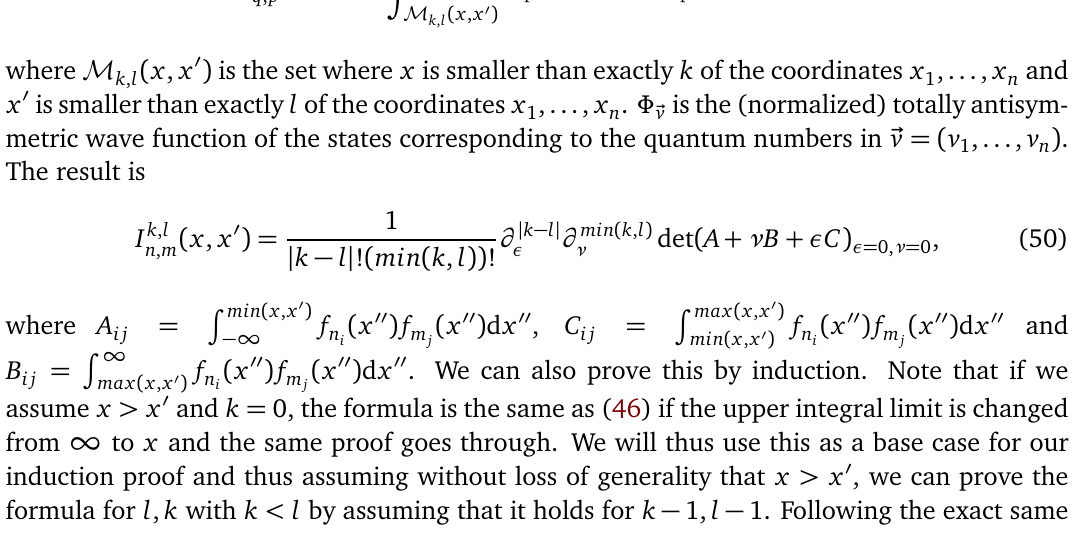
Figure 9: Position space density for the ground state at g system in the double well potential in Figure 1, for different basis sizes compared with the matrix product states method. The profile localized in the left well is the minority density and the other one is the majority